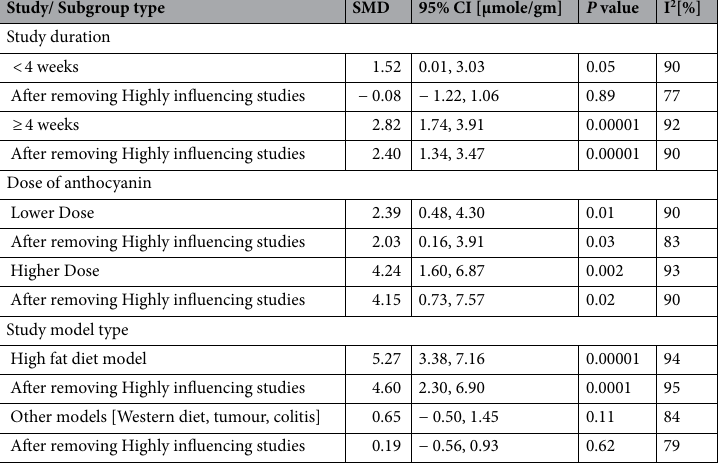
Treatment SMD Reg.